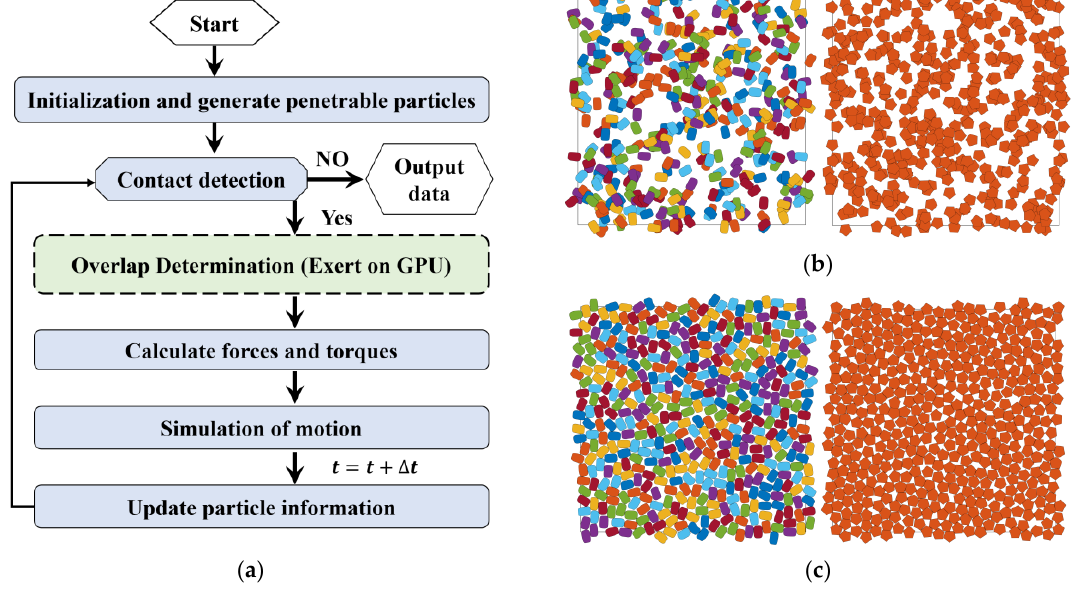
Figure 4. An example of dynamic packing super-ellipses (packing fraction of 80%, container = 100 × 100 , 𝐷 𝑒𝑞 = 5 , 𝑎 𝑏⁄ = 1.5 and 𝑚 = 1.5 ) and polygon (regular pentagon). ( a ) Flow chart for the packing process; ( b ) Initial state of packing, highly penetrable, particle number 𝑁 = 407 ; ( c ) Final state of packing, particle number 𝑁 = 451 and 450 (including periodic ones) for super-ellipse and regular pentagon, respectively.